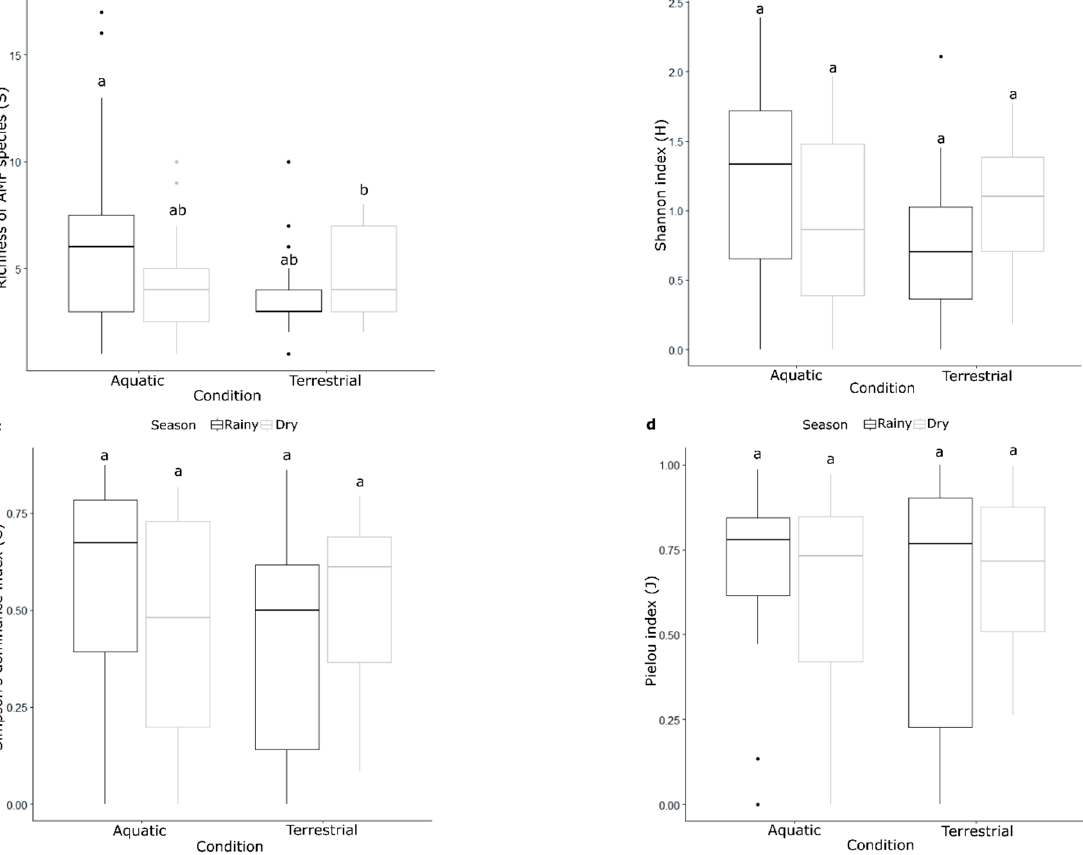
Figure 4. Species richness ( a ), Shannon diversity ( b ), Simpson dominance ( c ) and Pielou equitability ( d ) for AMF communities in aquatic/terrestrial and rainy/dry season conditions. Boxplots with different letters differ statistically by ANOVA ( p < 0.05).